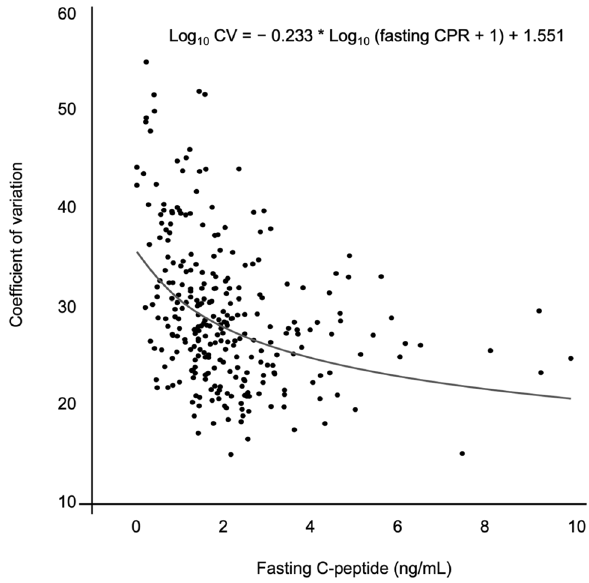
Figure 1. Scatter plot and prediction curve for fasting C-peptide versus coefficient of variation (n = 284).